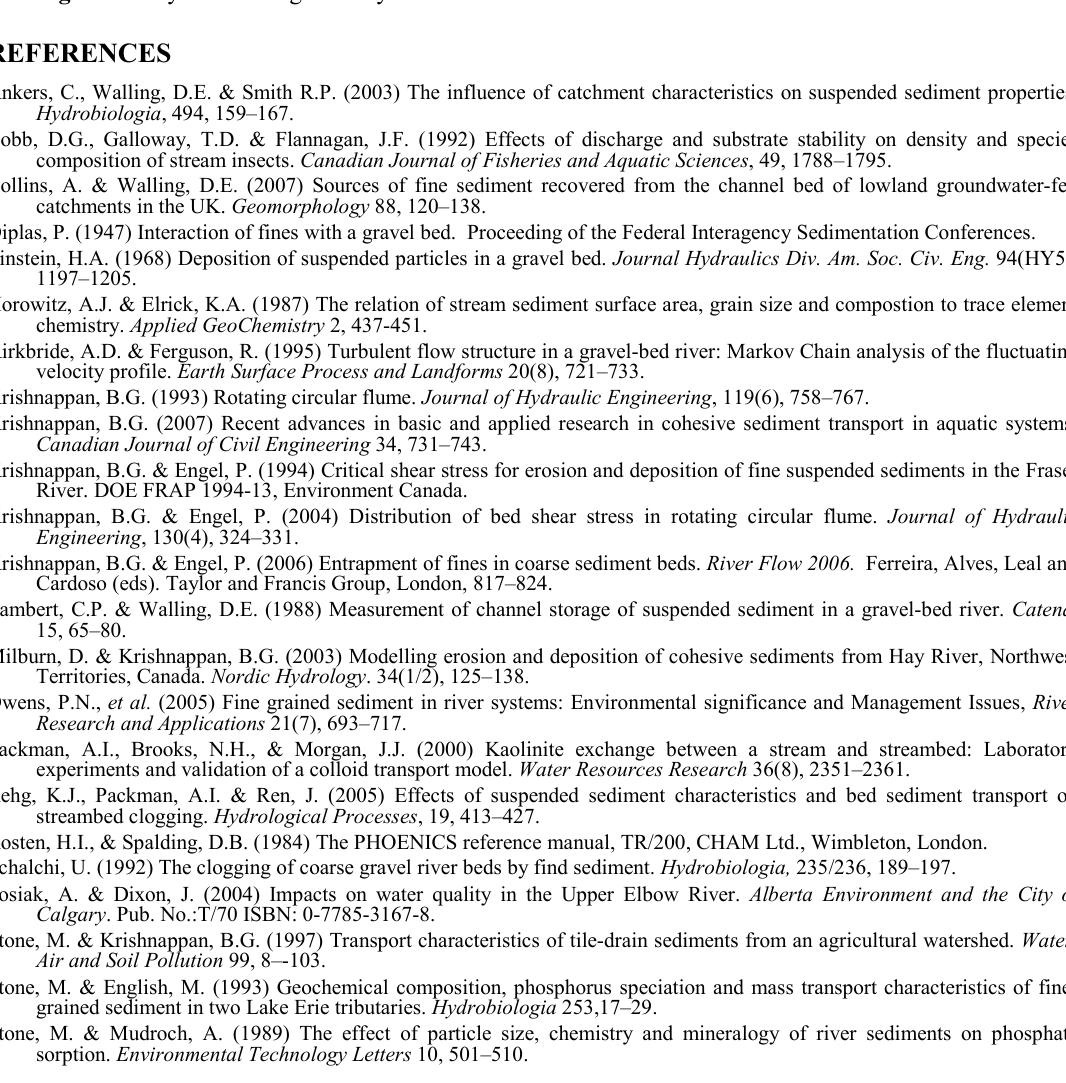
Fig. 5 Density and settling velocity of cohesive